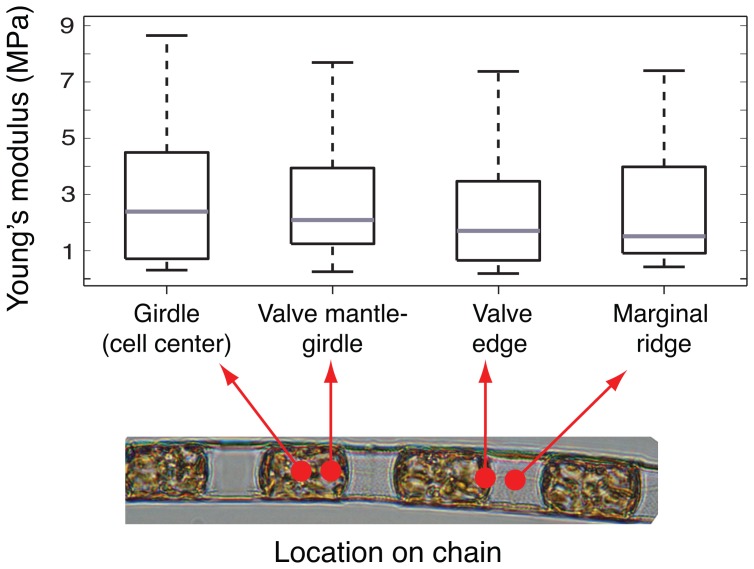
A box-and-whisker plot of the Young's modulus (E) as a function of location on the chains (girdle n = 15 samples; valve mantle-girdle transition n = 31 samples; valve edge n = 21 samples; marginal ridge n = 25 samples).On each box, the central gray line marks the median value, the edges of the box are the 25th and 75th percentiles, and the whiskers extend to the most extreme data points the algorithm considers not to be outliers.